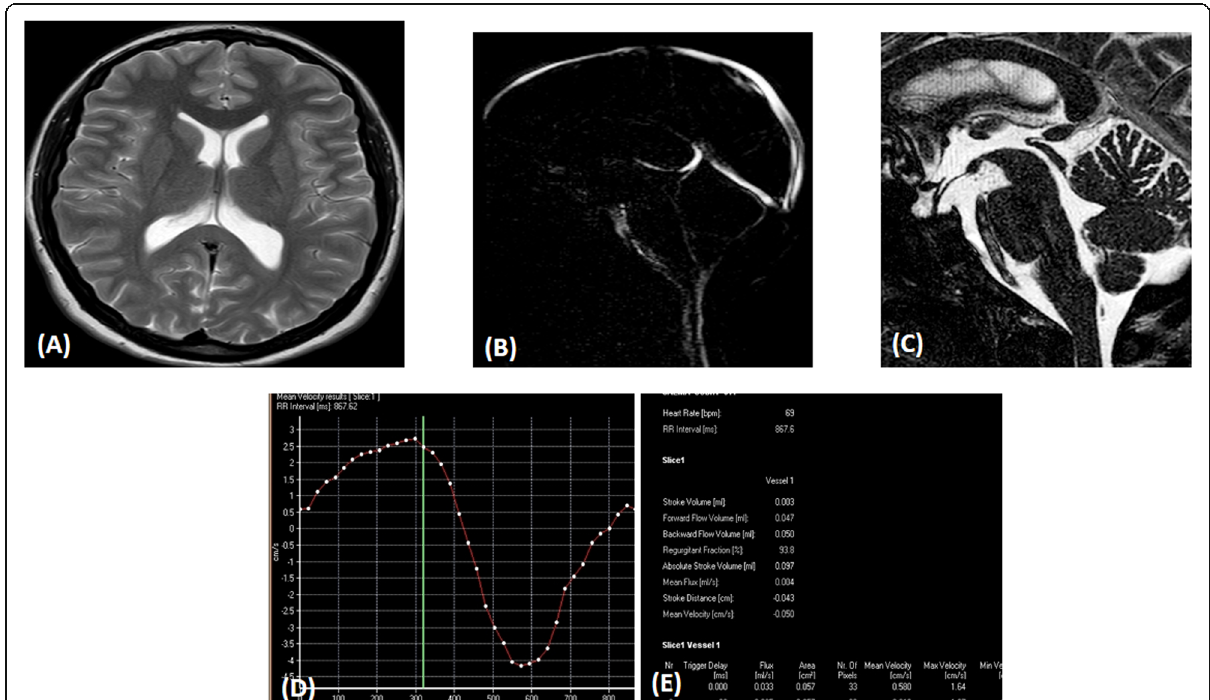
Fig. 5 Female patient aged 30 years old presented with visual impairment. MRI axial T2: Normal lateral ventricle. b 3D DRIVE image showing patent normal aqueduct. c Sagittal magnitude image showing CSF flow in the aqueduct of Sylvius as shades of white. d Velocity time curve showing CSF in both diastole (above the base line) and systole (below the base line). PDV = 2.6 cm/s, PSV = 4.1 cm/s, Vmax = (2.6 + 4.1)/2 = 3.35 cm/s. e CSF flow curve. Forward flow volume = 47 μ l and backward flow volume = 50 μ l, and so the SV = (47 + 50)/2 = 48.5 μ l/cycle. Diagnosis